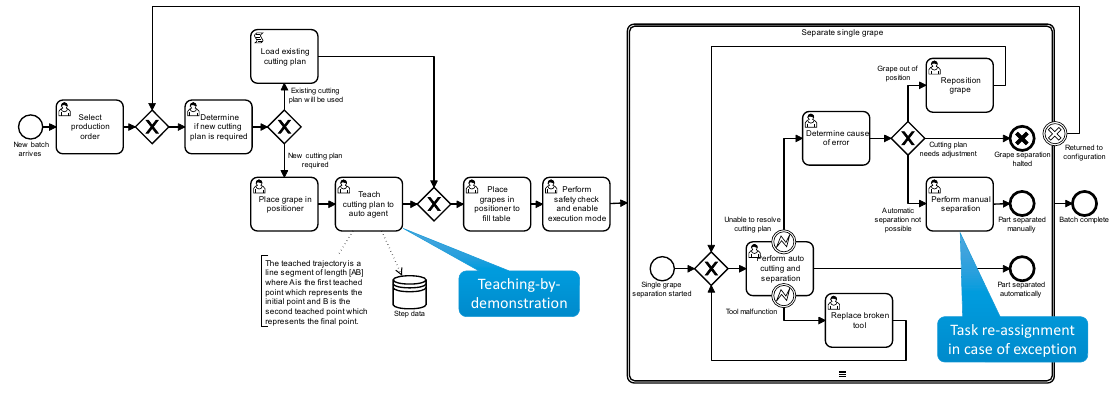
Figure 15. Grape separation process model of pilot case 3.